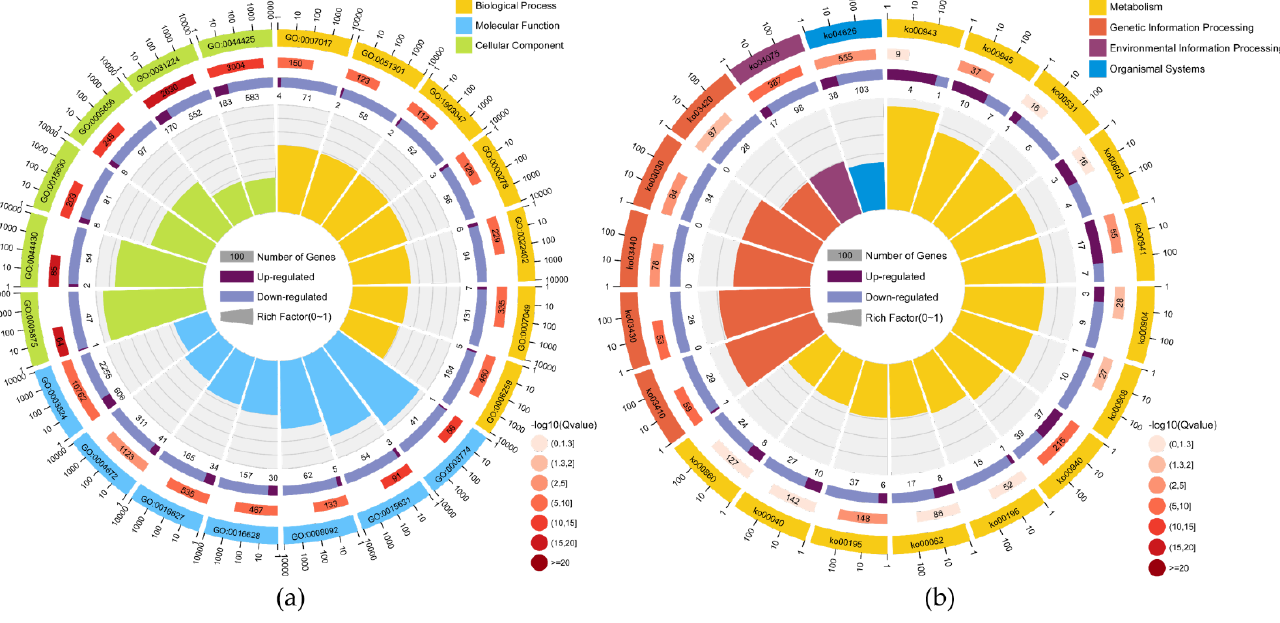
Figure 1. Top 20 of GO function ( a ) and KEGG pathway ( b ) enrichment of DEGs in the transcriptome of two developmental stages of P. volubilis seeds. The first circle: top 20 GO terms/KEGG pathways. The number outside of the circle is the coordinate ruler of the gene number. Different colors rep- resent different GO terms/KEGG A classes; the second circle: the number and Q value of the GO term/KEGG pathway in the background gene. The more genes, the longer the bars, and the smaller the Q -value, the redder the color; the Q -value is the p value corrected by the FDR method. The third circle: a bar chart of the proportion of up and down-regulated genes, dark purple represents the proportion of up-regulated genes, and light purple represents the proportion of down-regulated genes; the specific values are shown below. Fourth circle: RichFactor value of each KEGG